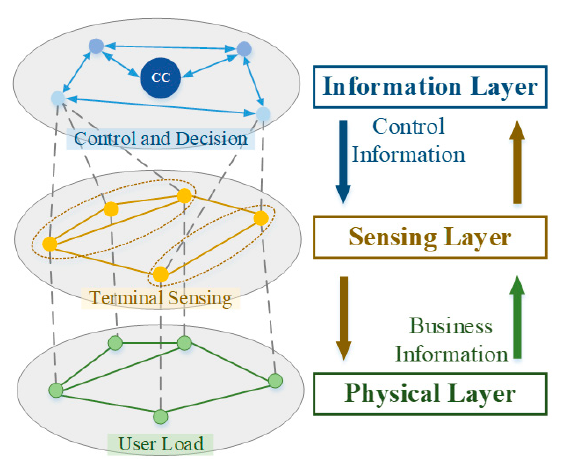
Figure 1. Cyber-physical system (CPS) structure under the power Internet of Things.